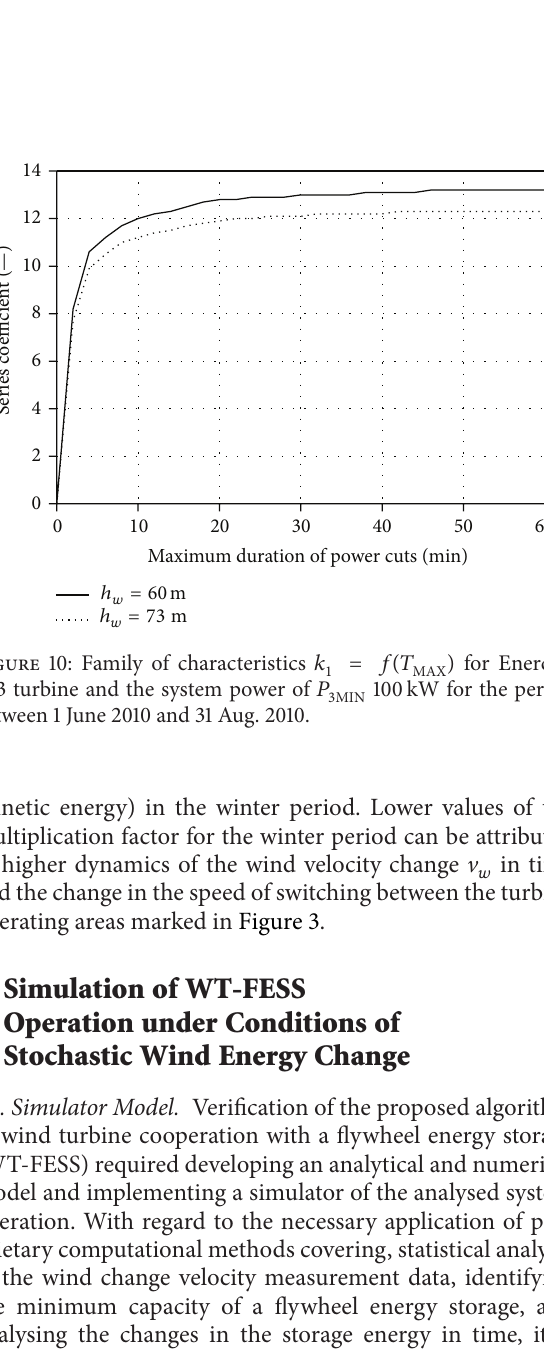
Figure 9: Family of characteristics 𝑘 1 = 𝑓(𝑇 turbine, height: ℎ 𝑤 = 60 m for the period between 1 June 2010 and 31 Aug. 2010.